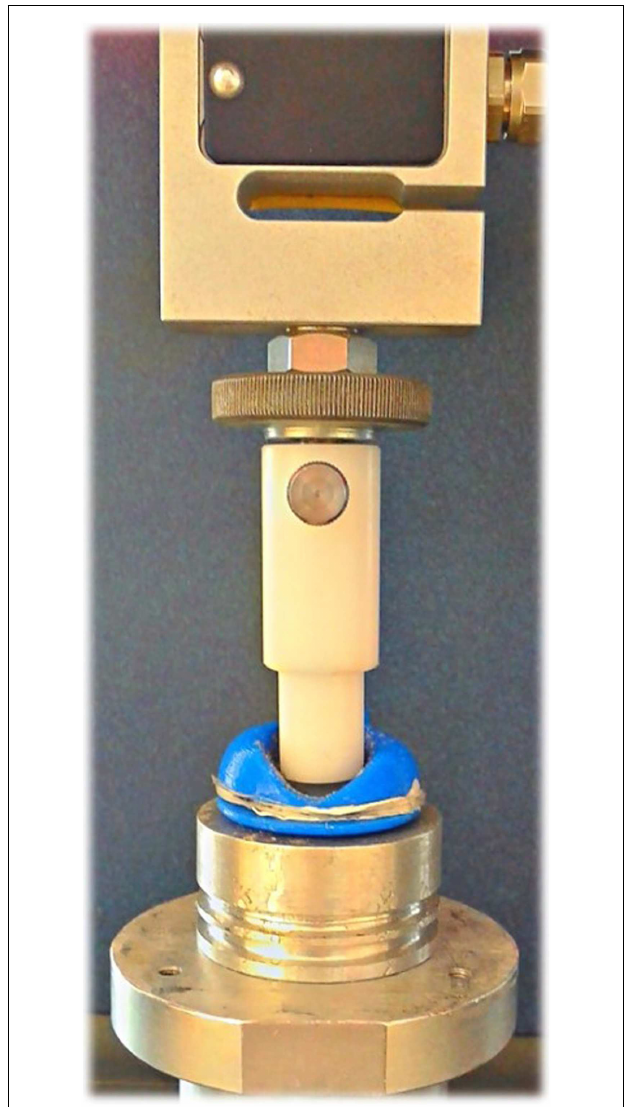
FIGURE 4 | Experimental setup for the mechanical and electromechanical characterization tests